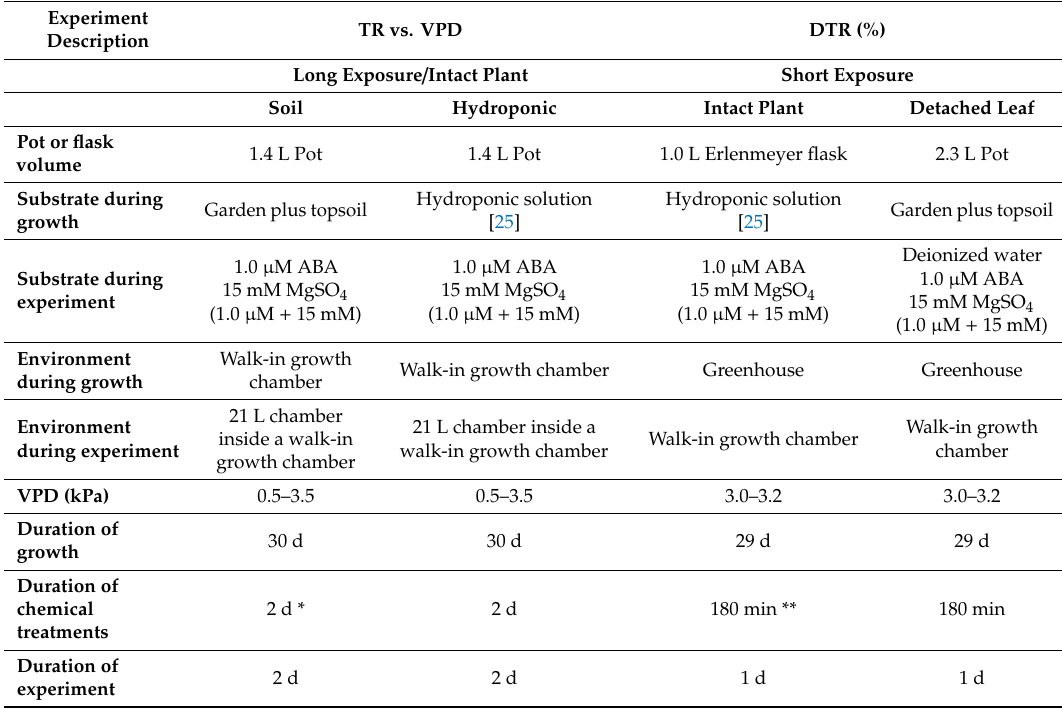
Table 2. Description of the conditions for the list of experiments plus the duration of each experiment. Experiment